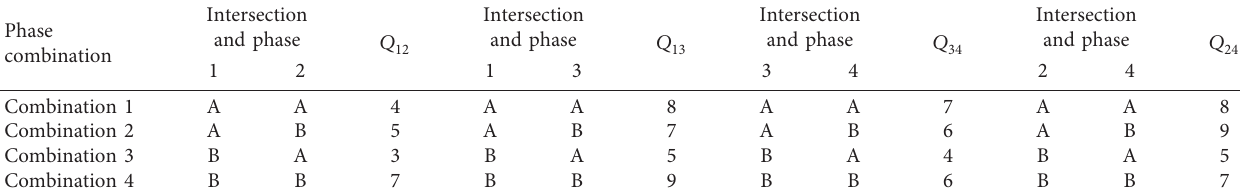
Table 1: The given Q -value matrix of the virtual road network.